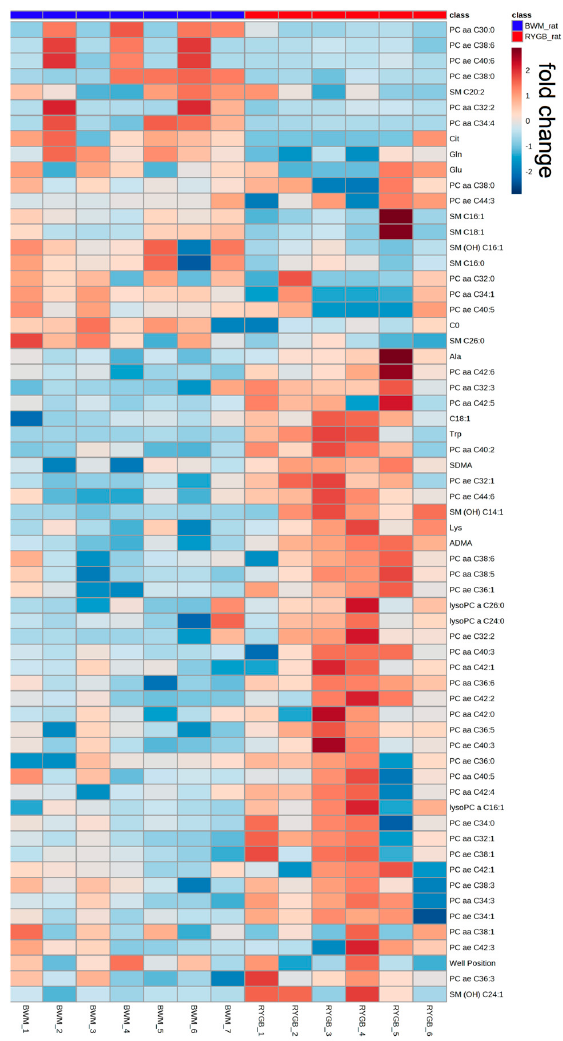
Figure 4. Heat map with the scaled relative abundance of 62 significantly different metabolites in BWM and RYGB rats four weeks postoperative visualized by metabolite hierarchical clustering. Abundance values represent row-wise z-scores of read counts. Each bar in the horizontal columns (which represent different rats) represents the expression intensity. Blue indicates a decreased level, red indicates an increased level. C, acylcarnitine; lysoPC, lysophosphatidylcholine; PC aa, phosphatidylcholine with ester bonding; PC ae phosphatidylcholine with ether bonding; SM, sphingolipid.